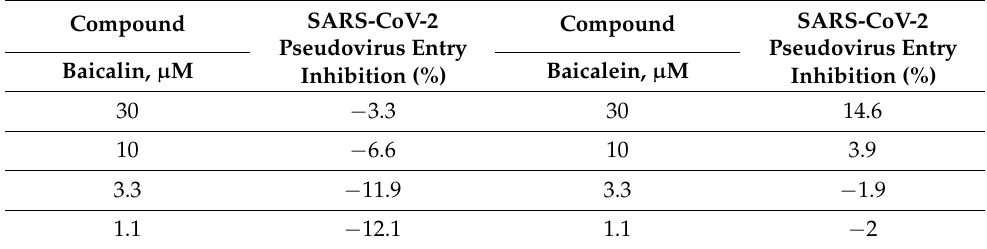
Table 2. SARS-CoV-2 pseudovirus entry assay. Different concentrations of each compound have been tested against entry stage of the SARS-CoV-2 pseudovirus. Pseudovirus entry inhibition (%) has been defined compared to the readout of untreated sample.